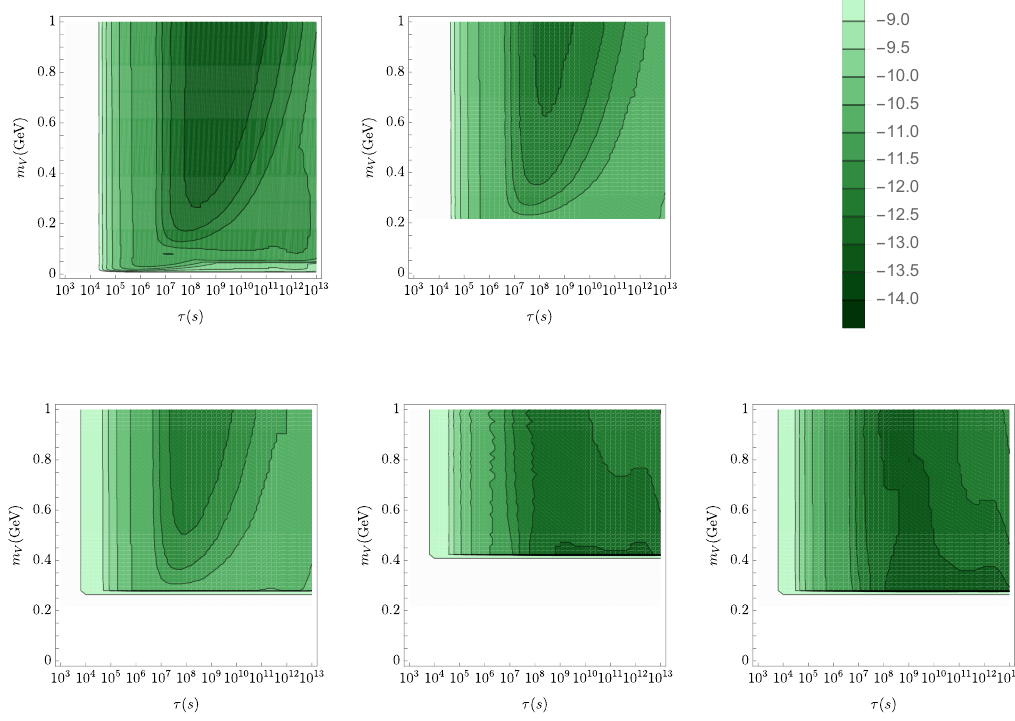
Figure 2 . BBN upper limits from electromagnetic e(cid:11)ects on the mass times yield log ( m V Y V = GeV) of a sub-GeV decaying particle V in the lifetime-mass plane for the exclusive de- 10 cays V ! e + e (cid:0) (upper left), V ! (cid:22) + (cid:22) (cid:0) (upper right), V ! (cid:25) + (cid:25) (cid:0) (lower left), V ! (cid:25) + (cid:25) (cid:0) (cid:25) 0 (lower middle), and V ! (cid:25) 0 (cid:13) (lower